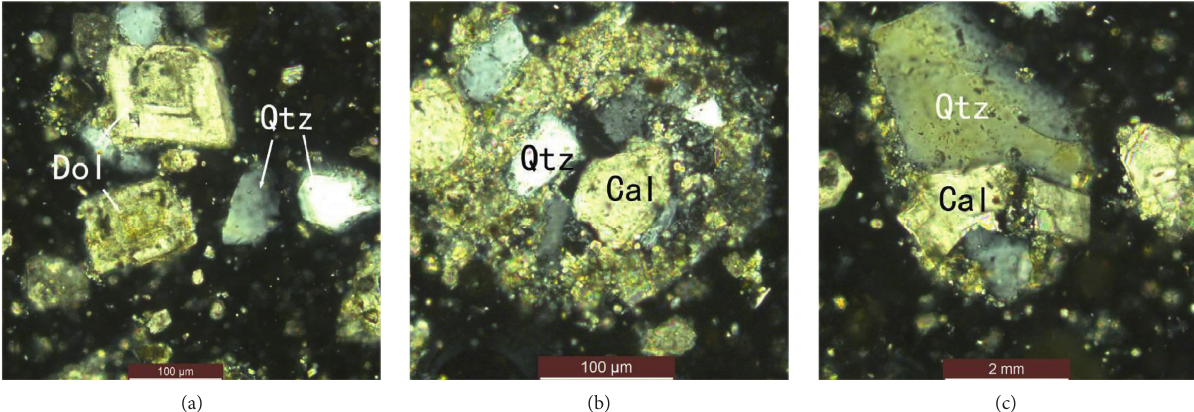
Figure 11: Embedded characteristics of carbonate minerals (dolomite and calcite) (TCPL represent transmitted crossed polarized light). (a) Euhedral rhombohedral dolomite (Dol), TCPL. (b) Calcite (Cal) and quartz (Qtz) connected, TCPL. (c) Calcite (Cal) and quartz (Qtz) connected, TCPL.